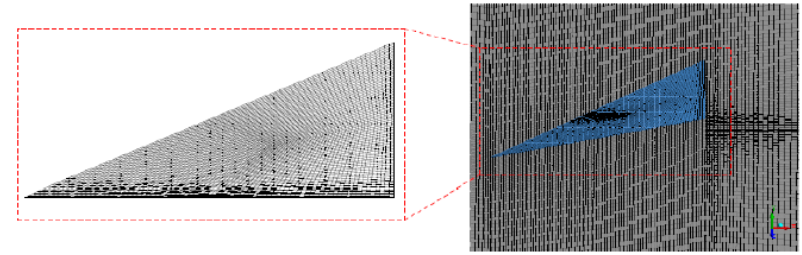
Figure 1. Computational mesh.